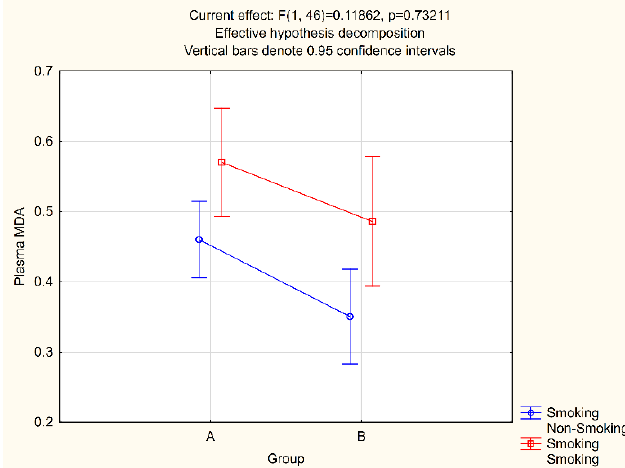
Figure 4. Plasma MDA and smoking interaction.